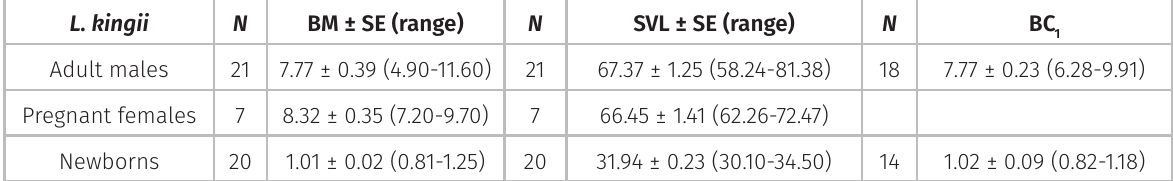
Table I. The mean ± standard error (SE), range, and sample size ( N ) of body mass (BM, g) and snout-vent length (SVL, mm) for adult males, pregnant females, and newborns, and body condition the first day in the laboratory (BC ) for adult males and newborns of Liolaemus kingii are presented. 1 L.